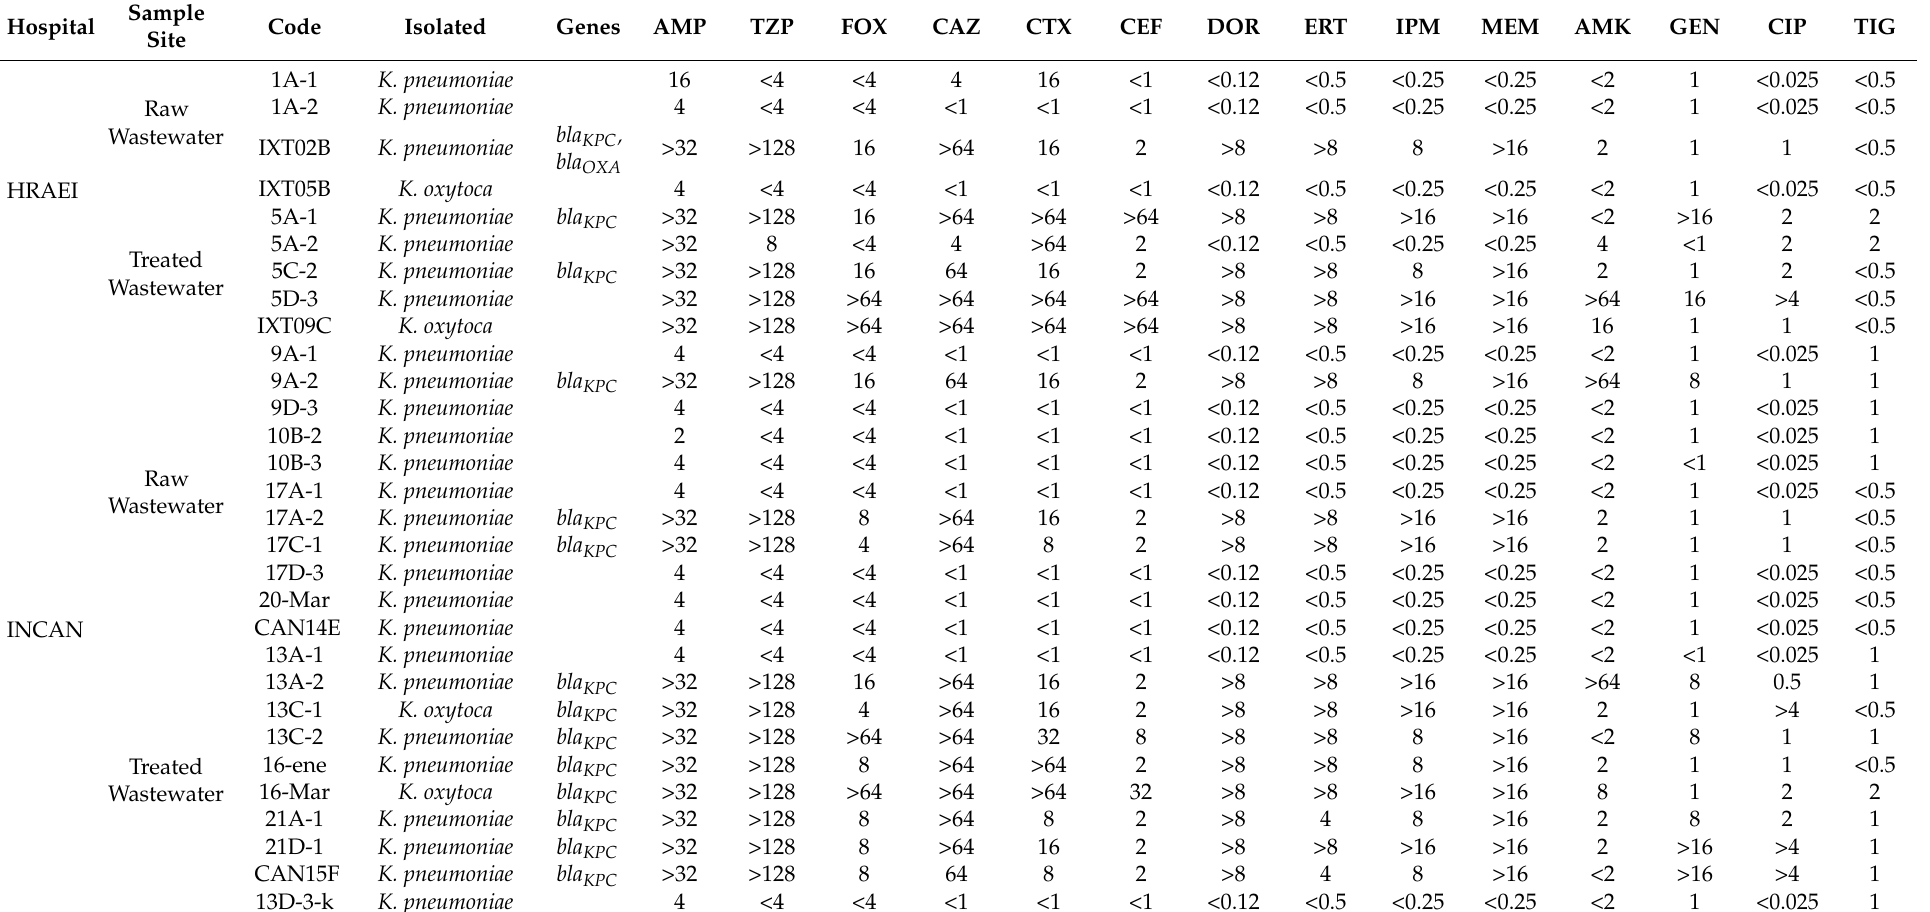
Table 1. Phenotyping properties of carbapenemase-producing Klebsiella spp. present in wastewater treatment plant (WWTP) of Hospital Regional de